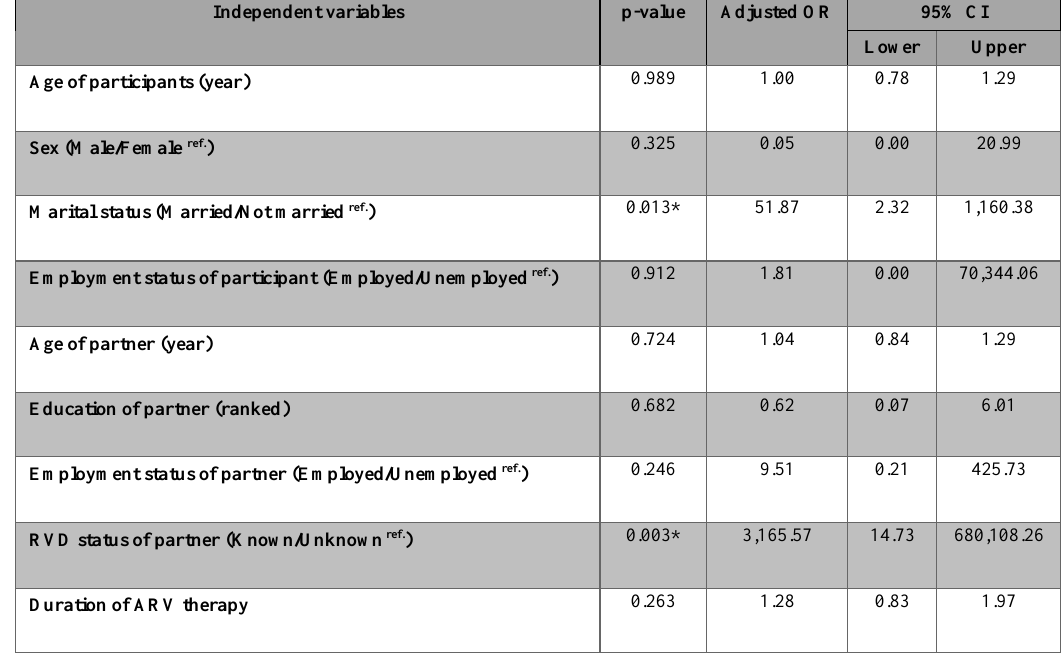
Table 4. Multiple Logistic Regression of Disclosure of HIV Status to Partner and Associated